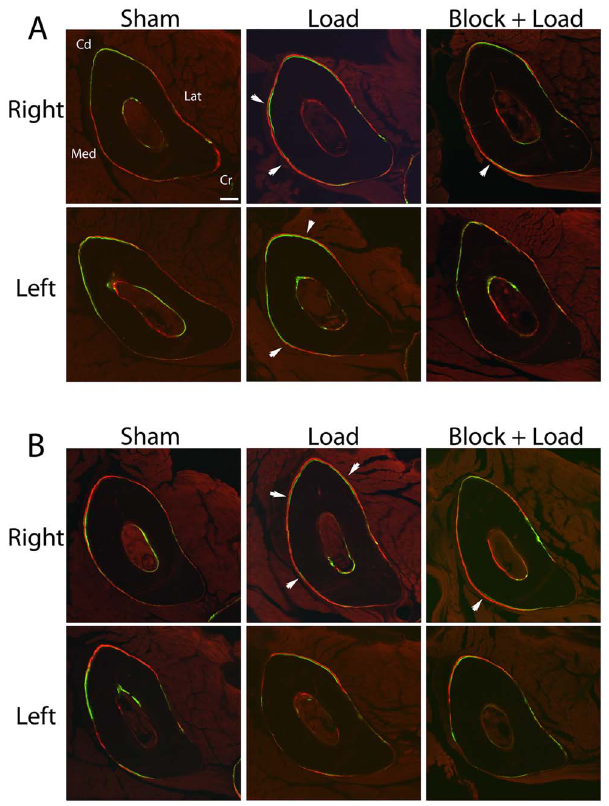
Fig. 3. Fluorochome-labeled new bone formation in CGRP a wildtype and knockout mice. Cyclic loading of the right ulna in wildtype ( A ) and knockout mice ( B ) induced an adaptive response with increased periosteal bone formation (white arrows). Blocking of periosteal bone formation with responses was more evident in the CGRP a knockout mice. Bar 5 110 m m. Cd, caudal; Cr, cranial; Lat, lateral; Med, medial. Sham – sham loaded group, Load – loaded group, Block + Load – BPA treatment before loading. n 5 11–14